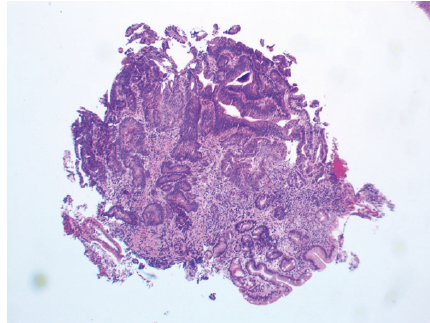
Figure 1: Stomach incisural mass biopsy on low microscopic power showing gastric mucosa with intestinal metaplasia and involvement by adenocarcinoma with invasion into the submucosa.